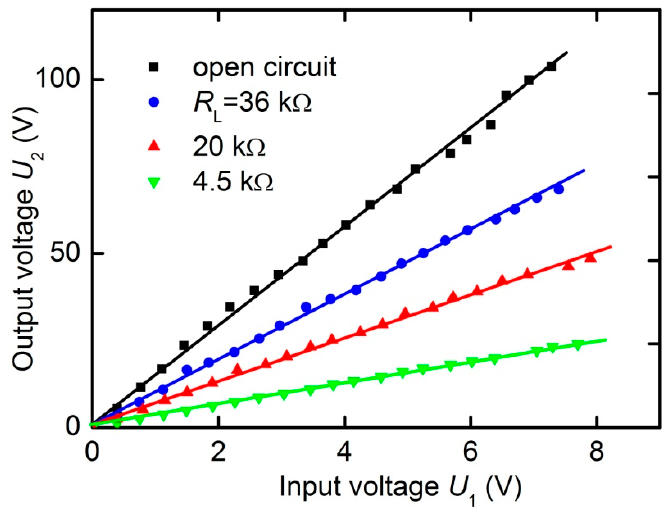
Figure 9. Dependences of the output voltage U 2 on the input voltage U 1 at the resonance frequency f 0 and H m = 6.37 kA/m for different load resistances R L (4.5, 20 and 36 k Ω ) and under open-circuit conditions. Solid lines are the linear approximations.